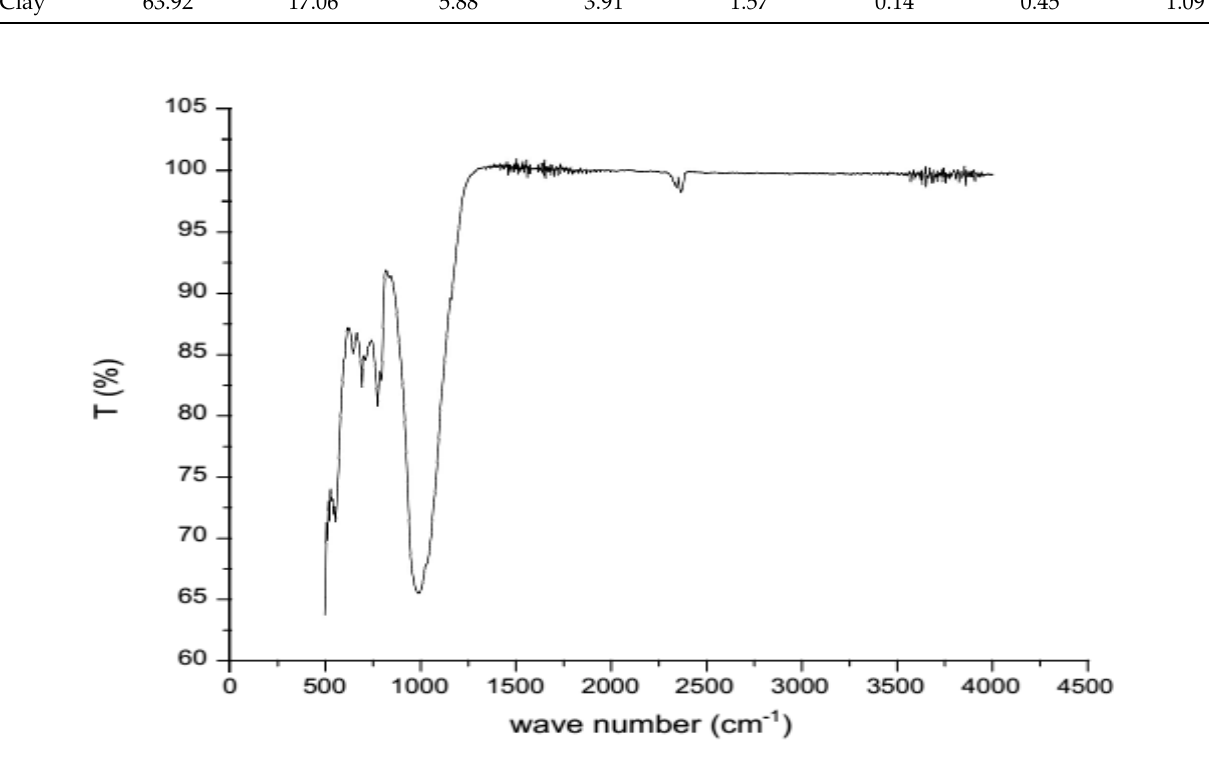
Figure 2. FTIR peaks of thermally activated clay.